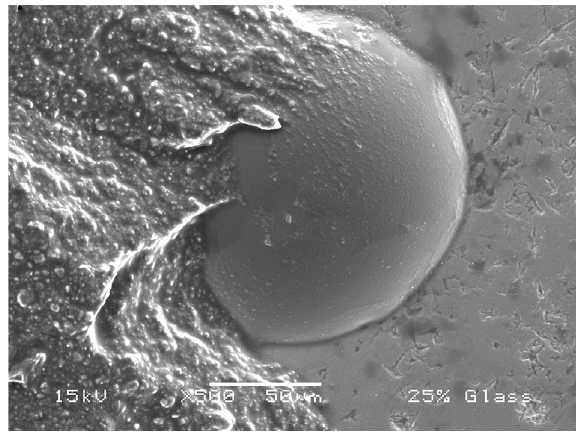
Figure 2. Resin cement adhered to the glass bead on the zirconia surface.